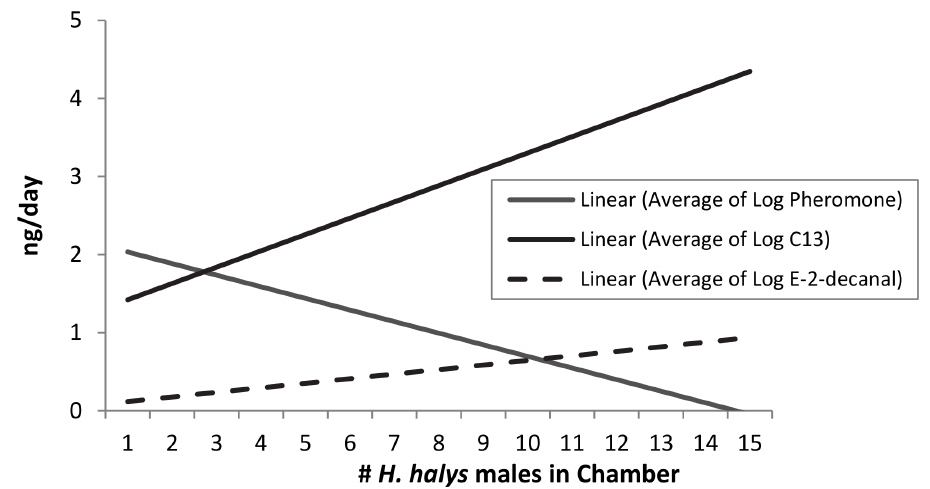
transformed data using repeated measures ANOVA for Compound = subject, # males (subject). Pheromone F 1,71 − 6.634; p < 0.0001; C13 F 1,71 − 5.701; p = 0.001; E -2-decenal F 1,71 − 1.617; p = 0.003. Regression equations: Pheromone = -0.17x + 2.52; C13 = 0.22x + 1.15; E -2-decenal = -0.773x + 0.290. The relationship between C13 and the male-specific compounds was analyzed via ANOVA using pairwise correlations. Pairwise correlations, p < 0.0001. The C13 and male specific compounds interaction overlaps at 2.50